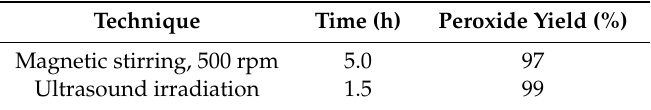
ff ect of magnetic stirring or ultrasound irradiation. Reaction conditions: Table 1. The effect of magnetic stirring or ultrasound irradiation. Reaction conditions: 1-bromobutane Table 1. The e